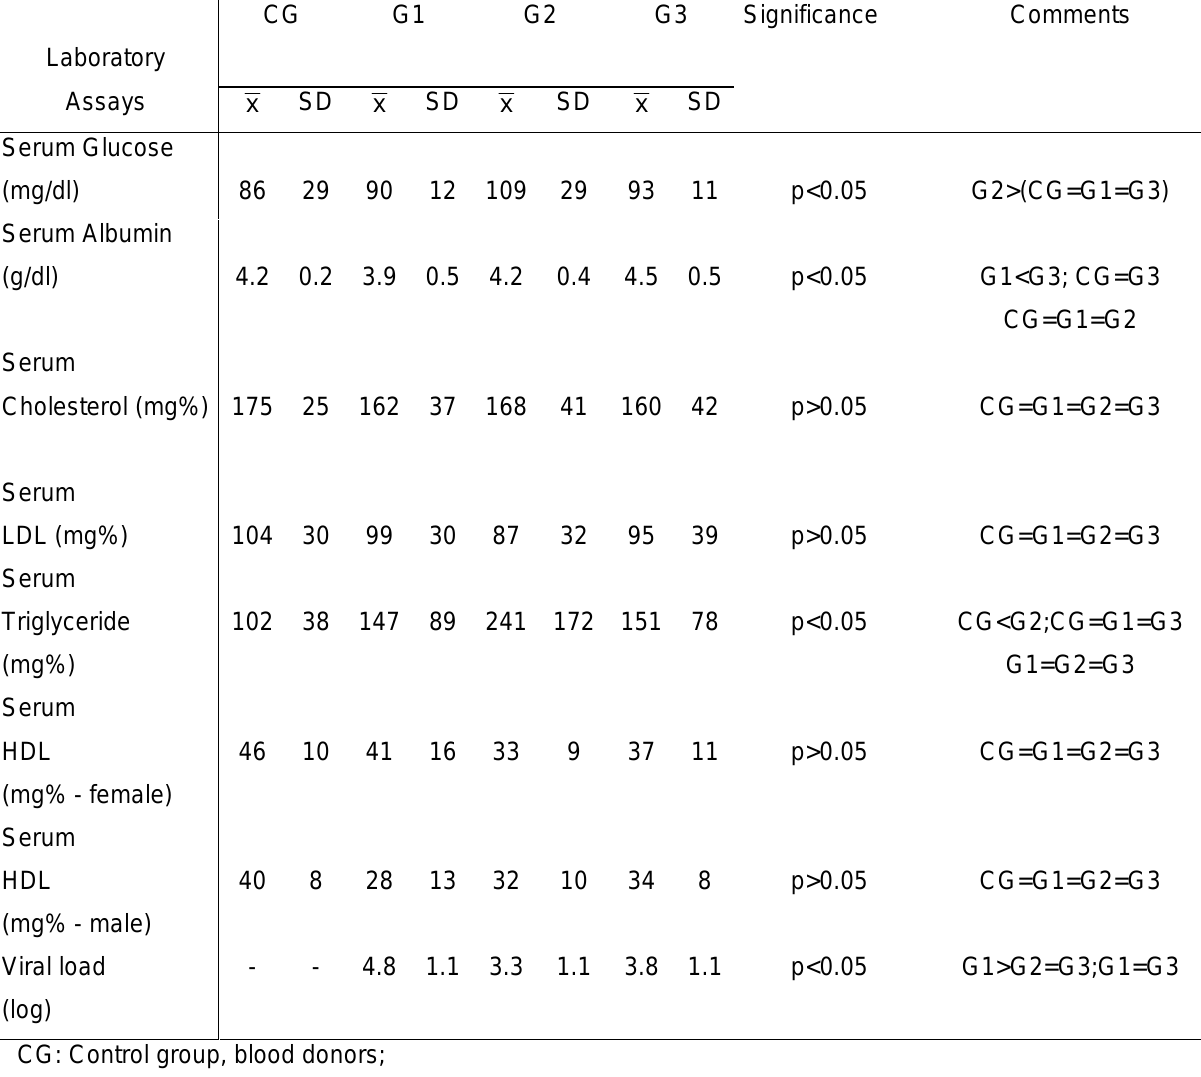
Table 3. Mean ( x ) and standard deviation (SD) of the serum parameters and viral load (copies/ml) in logarithm of the 62 subjects, HIV-1 infected or not, according to the study